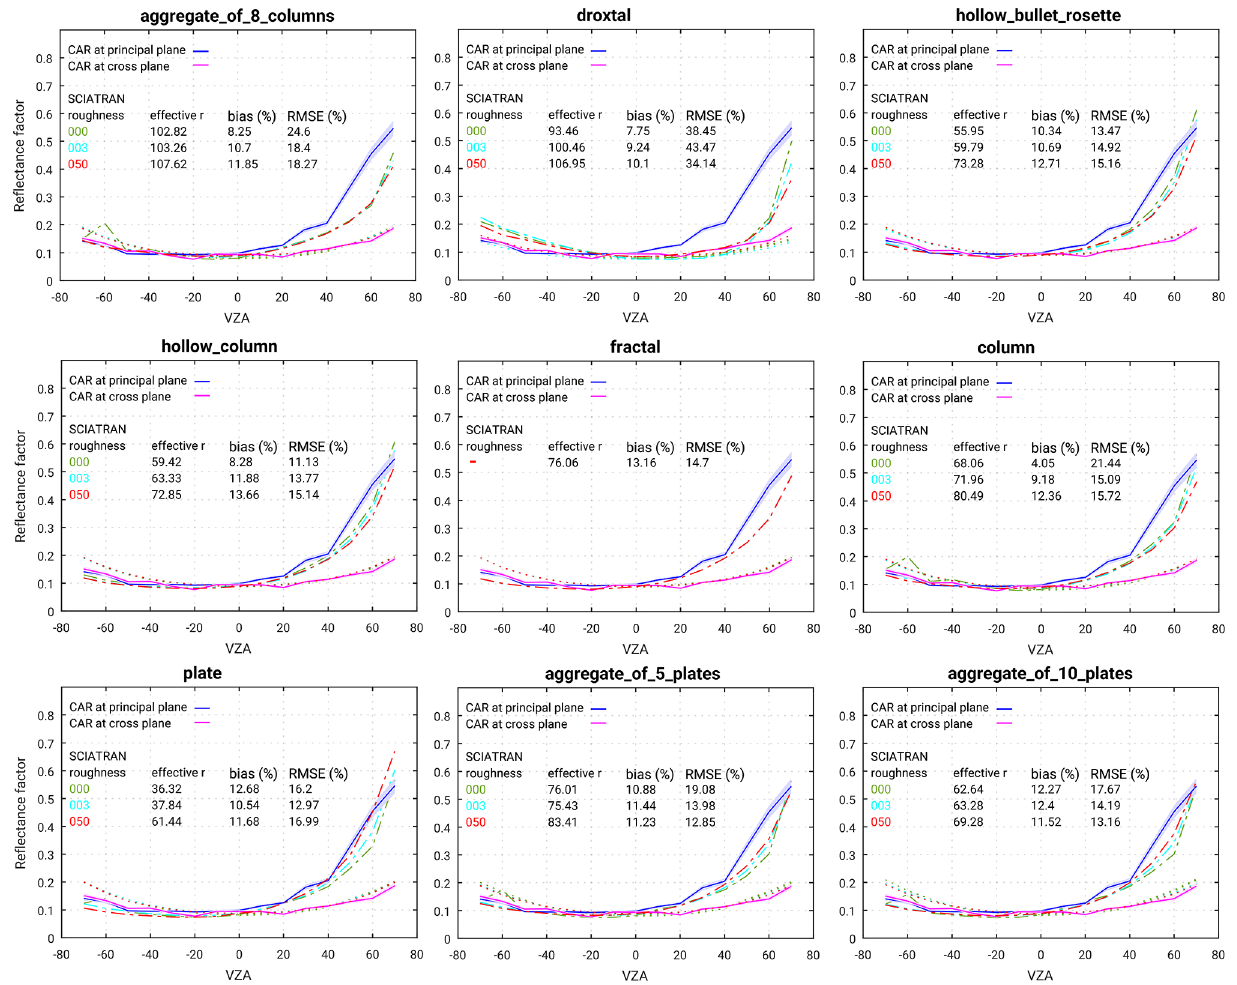
Figure 7. The same as Fig. 6 but the measurements by the CAR instrument were performed on 15 April at 181m flight altitude over fresh